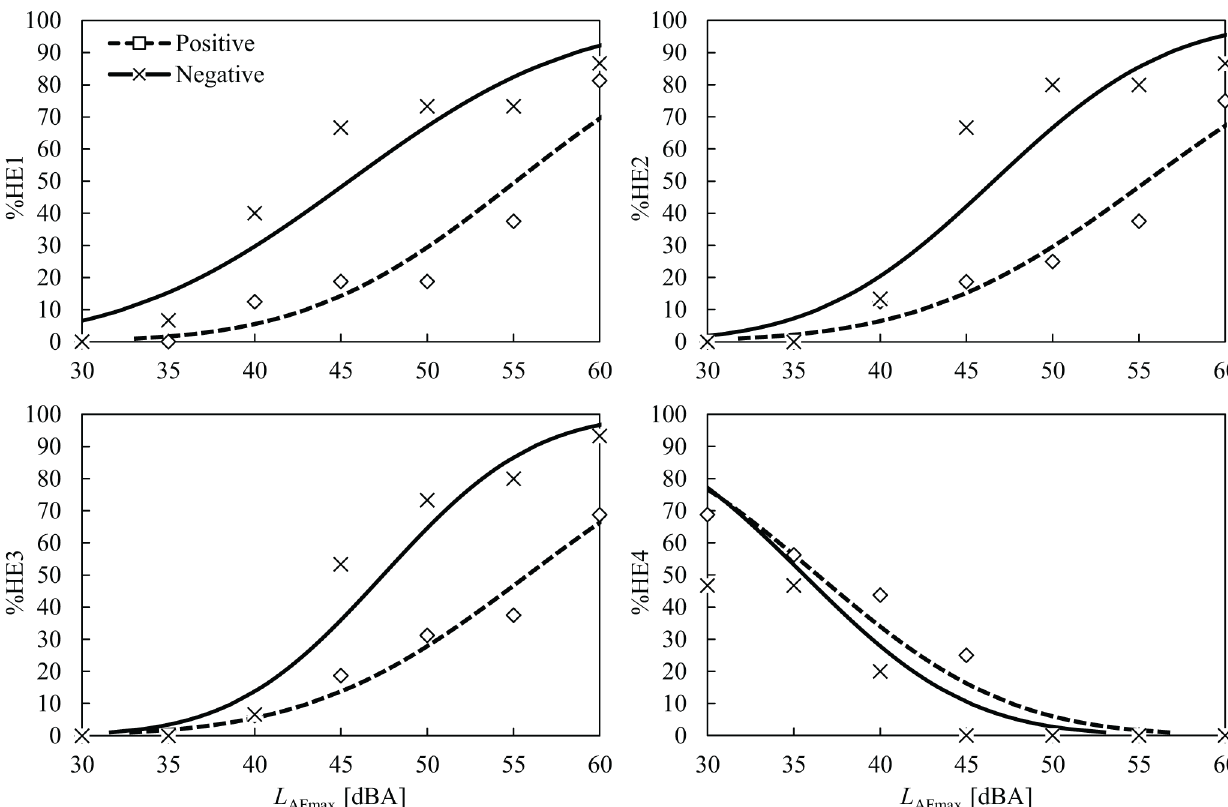
Fig 7. Percentage of high emotion ratings (%HE1–%HE4) for the positive ( □ ) and negative ( × ) attitude groups as a function of noise level. Probit regression curves are also presented for both groups.